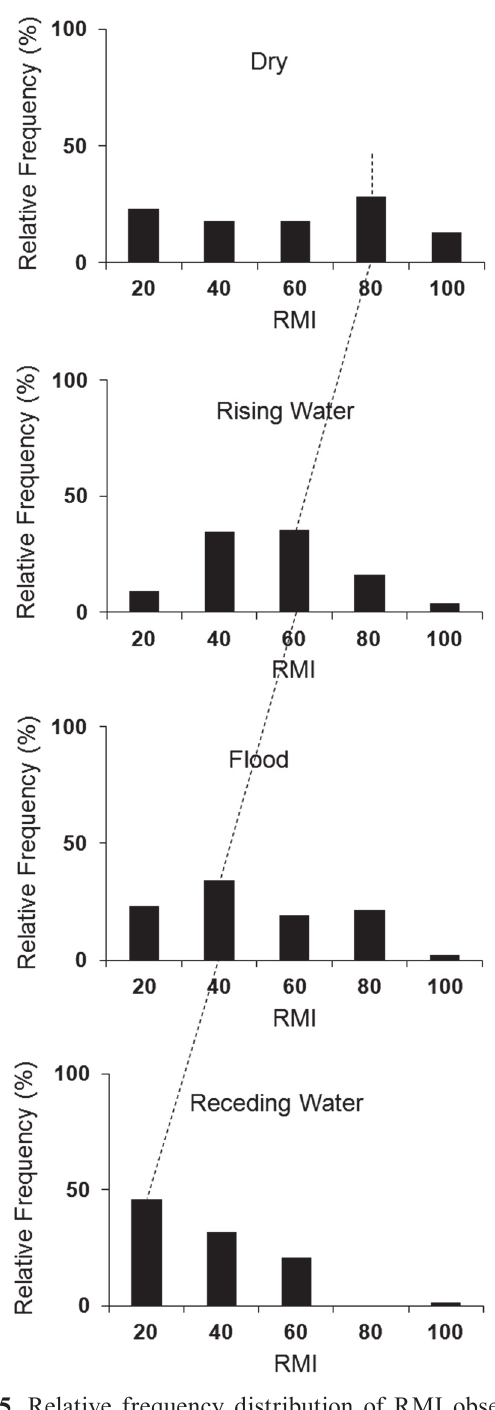
Fig. 5. Relative frequency distribution of RMI observed on scales of Cichla temensis from the middle rio Negro for each hydrological